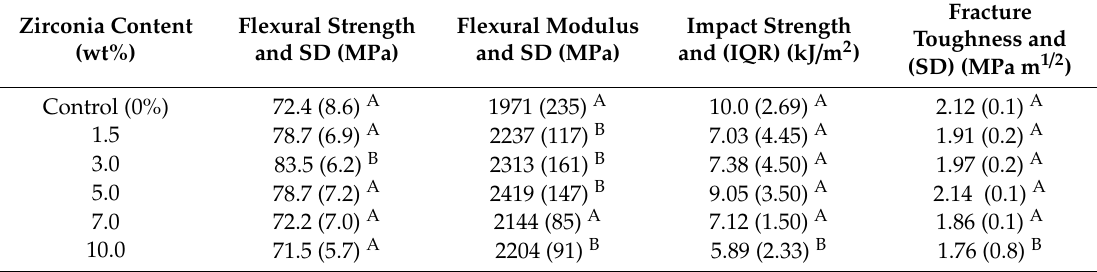
Table 2. Mean (MPa) Standard deviation (SD) values of flexural strength, flexural modulus and